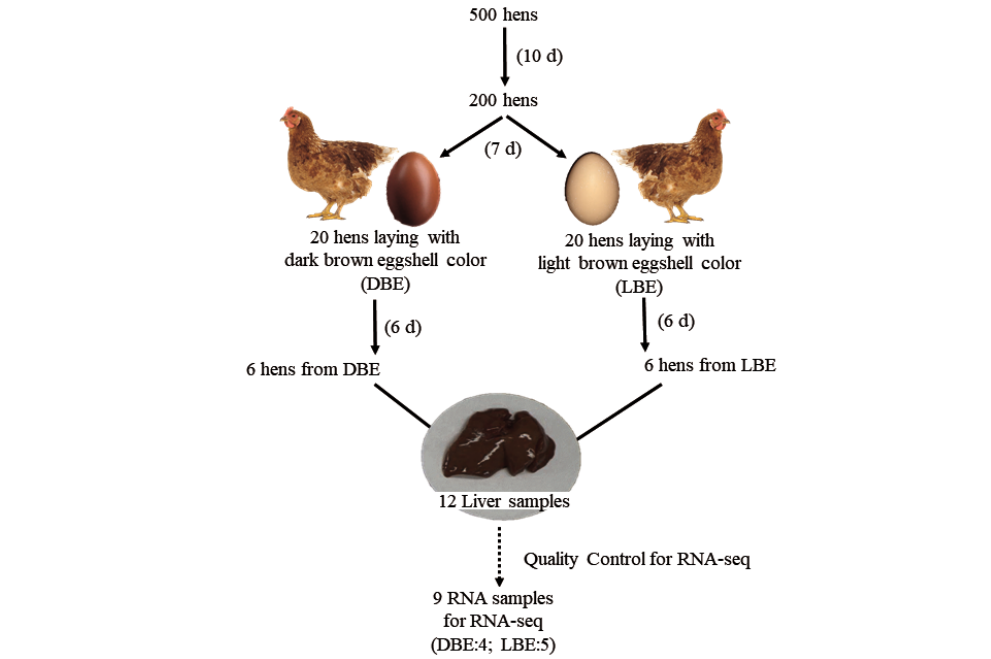
Figure 1. The diagram of the experimental strategy for RNA-Seq. The day in the blank means the recording period of eggshell color. Six hens from each group were selected for RNA-Seq. However, during the quality control process, 2 samples from dark brown eggshell (DBE) group and 1 sam- ple from light brown eggshell (LBE) group were removed, and thus, were not subject to RNA-seq